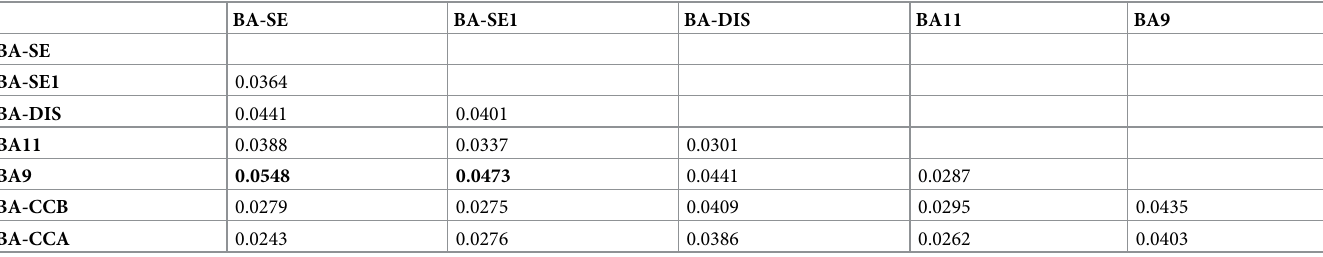
Table 1. Intergenotypic p -distances in the partial G gene calculated between Seoul RSV-B strains.